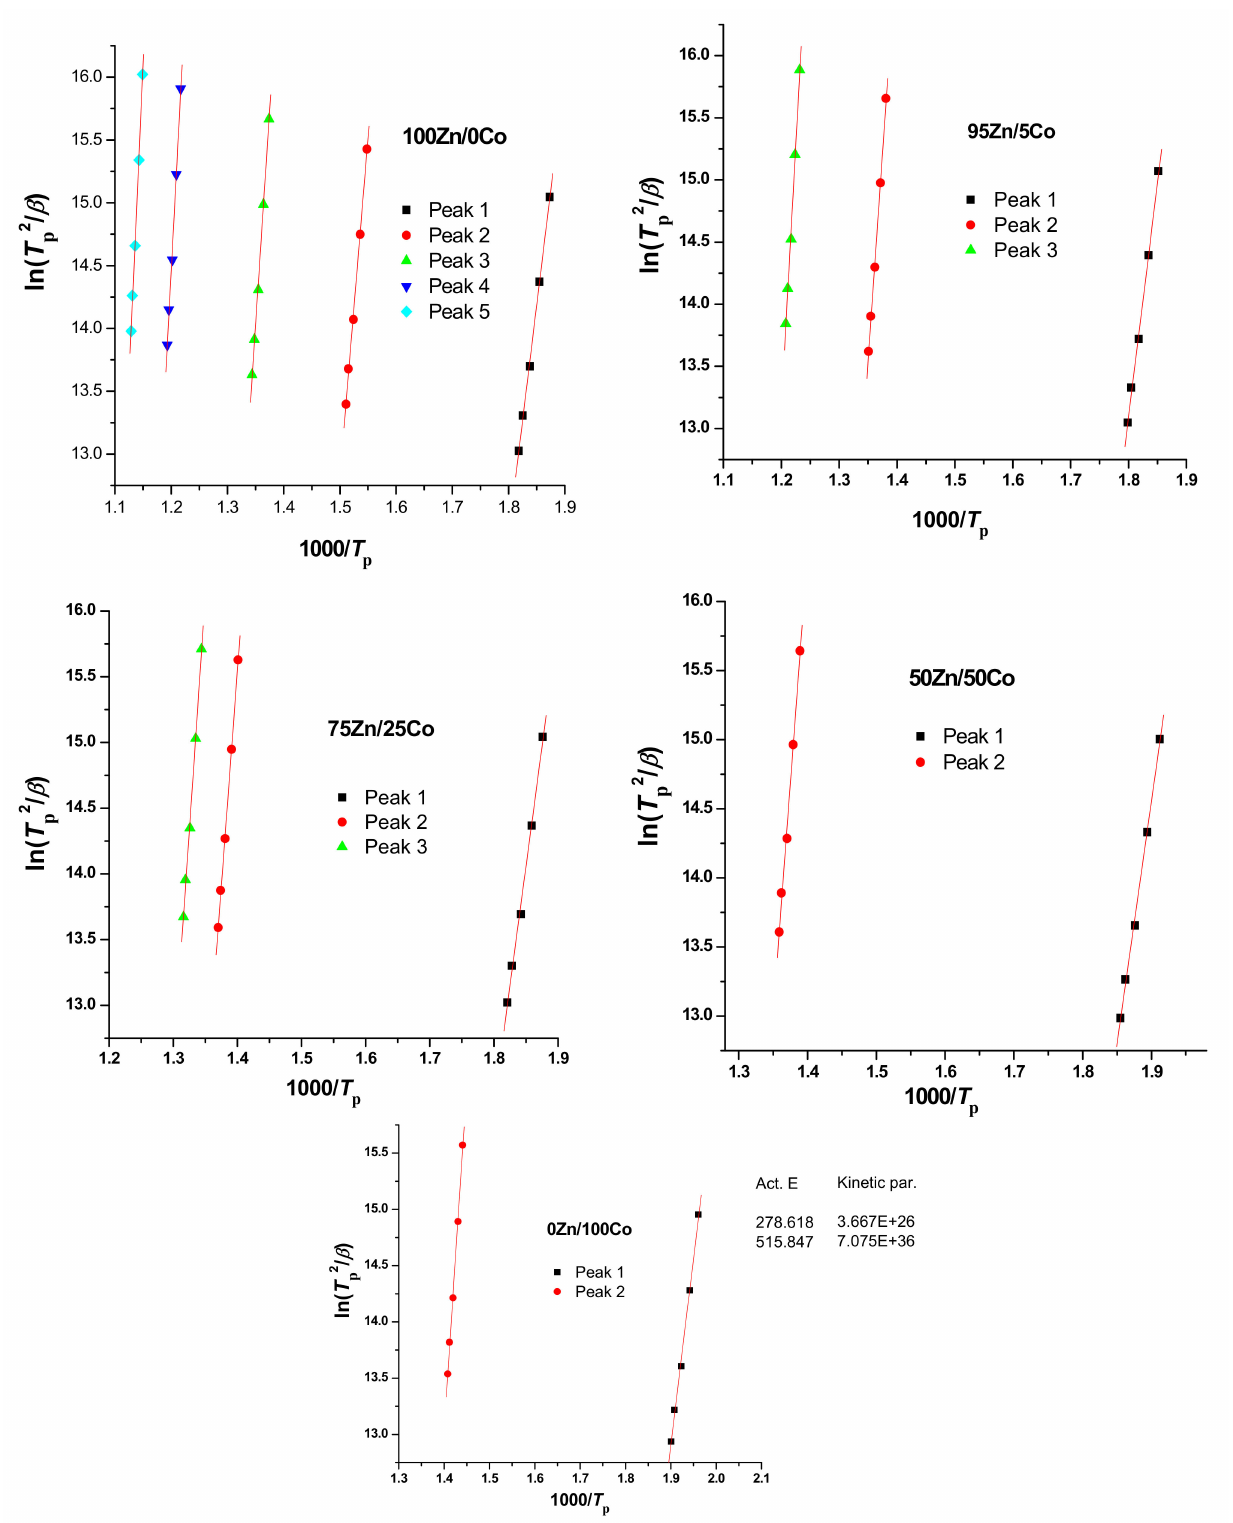
(cid:16) (cid:17) T 2 p / β vs. 1000 /T p of the Zn 1-x Co x -ZIF-8 sample under